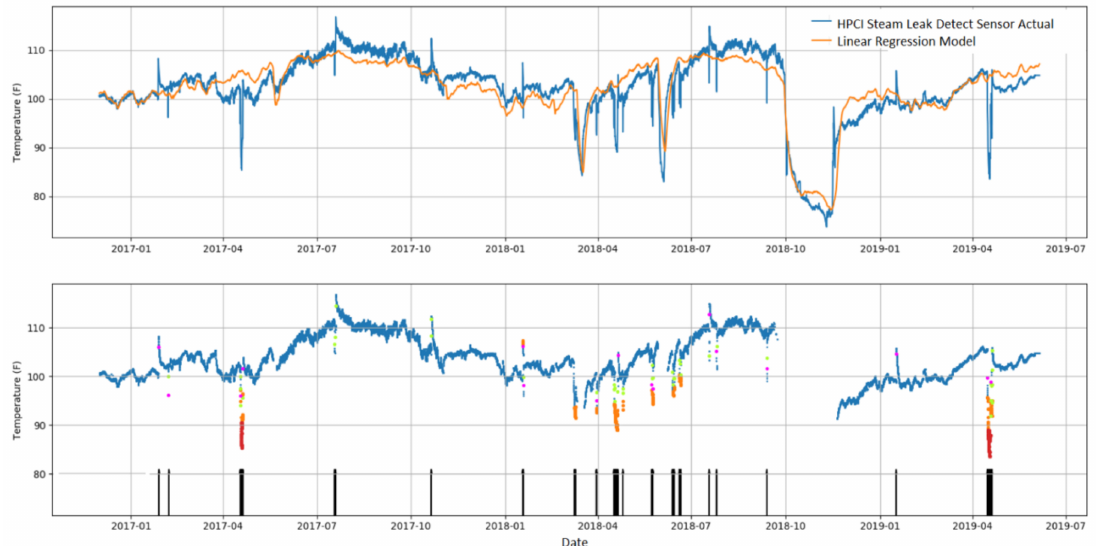
Figure 10. Results of the physics-based linear-regression method for anomaly detection (The top plot shows the actual steam leak sensor data [blue] and the estimated HPCI room temperature generated by the linear regression model [orange], while the bottom plot shows the clustering results as they correspond in time).